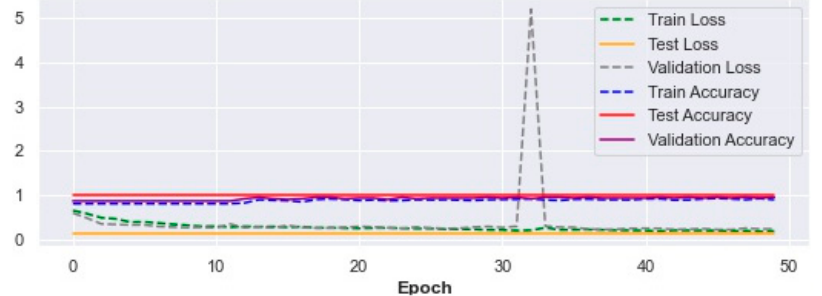
Figure 5. Train, test, and validation accuracy and loss results in the 6p-SAFE model.